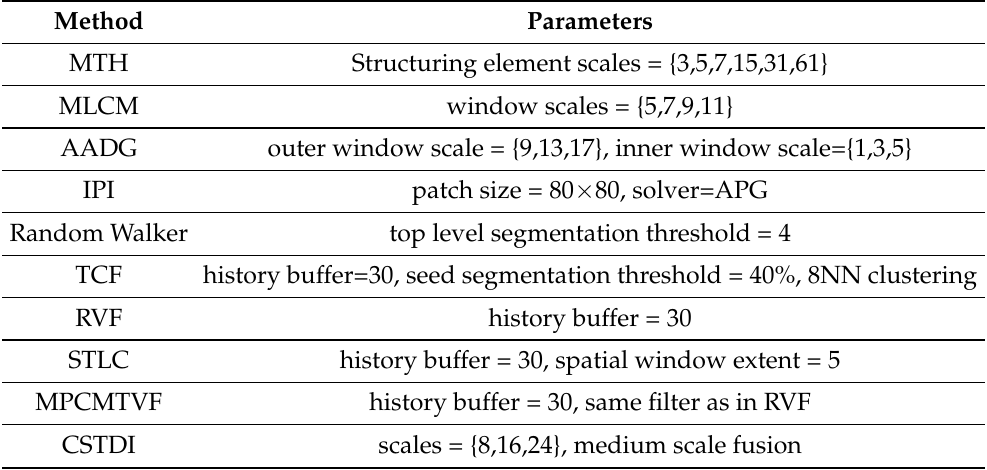
Table 1. Parameter settings of different